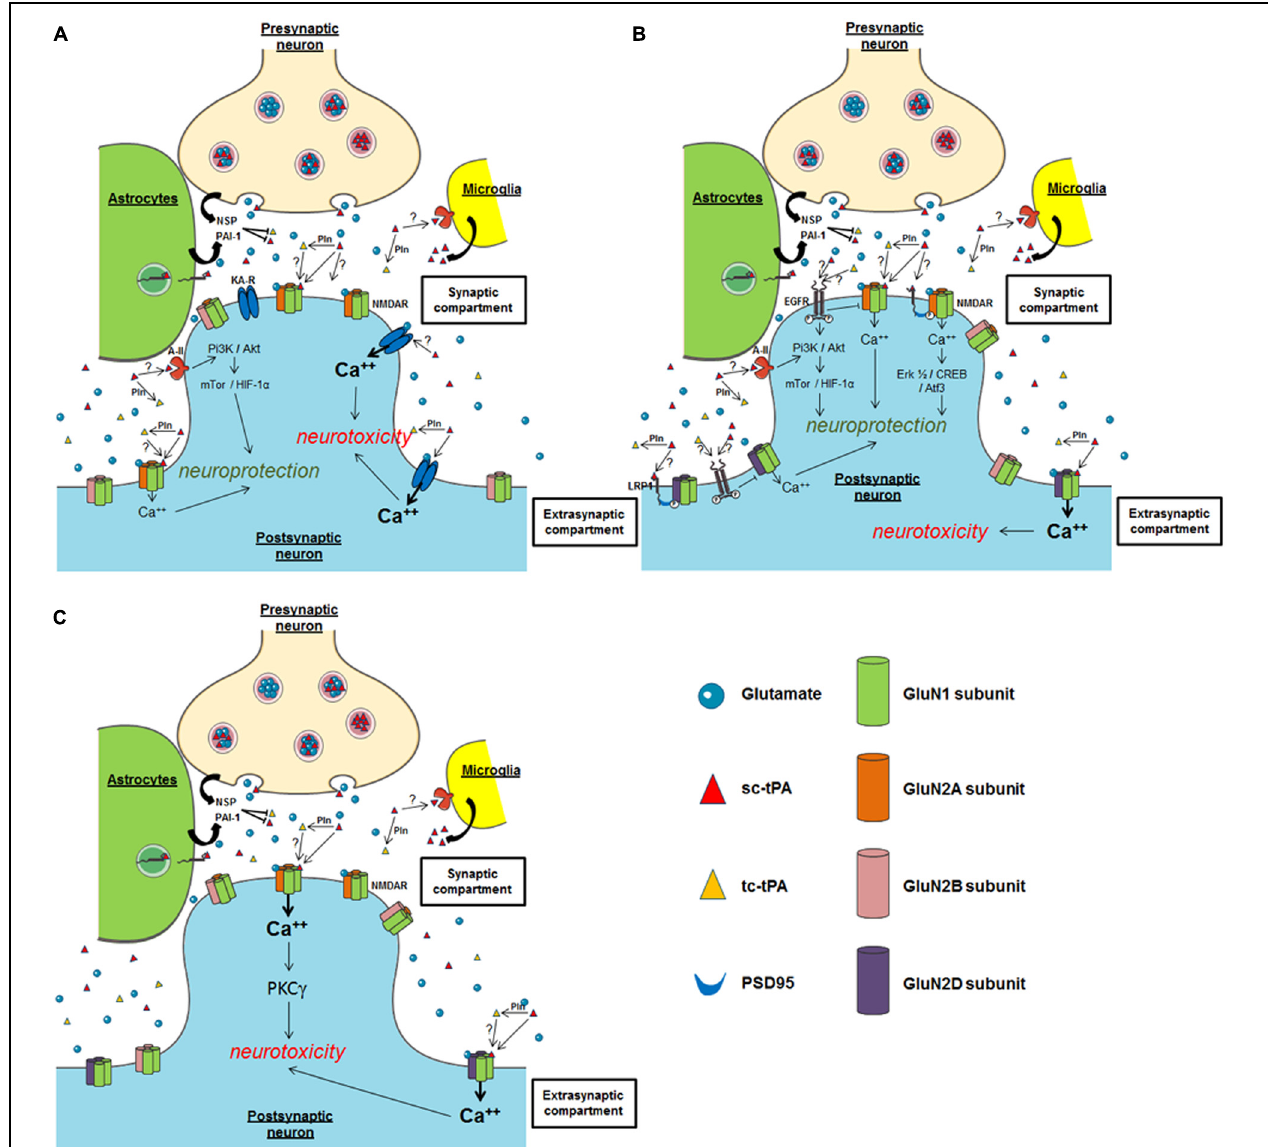
FIGURE 3 | Possible mechanisms of tPA on neuronal survival. (A) Hippocampal neurons; (B) cortical neurons; (C) cerebellar neurons. NSP, neuroserpin; Pln, plasmin; PAI-1, plasminogen activator inhibitor-1; NMDAR, N -methyl- D -aspartate receptor; EGFR, epidermal growth factor receptor; KA-R, kainate receptor; A-II, annexin II